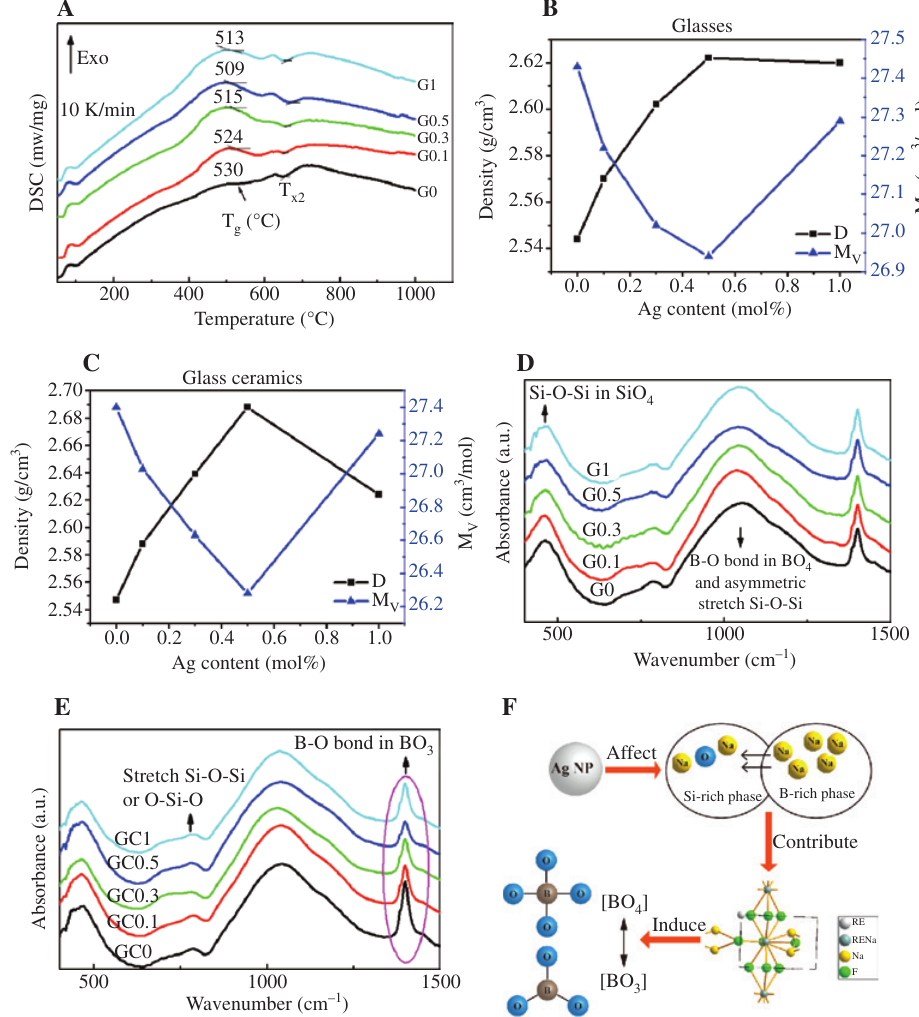
Figure 2: Effect of Ag + on the thermal properties and structure variation of glasses and GCs. (A) DSC curves of the borosilicate glasses; densities and molar volume of glasses (B) and GCs (C); Fourier transform infrared absorption spectra of glasses (D) and GCs (E); (F) schematic structure variation of glass due to the introduction of Ag